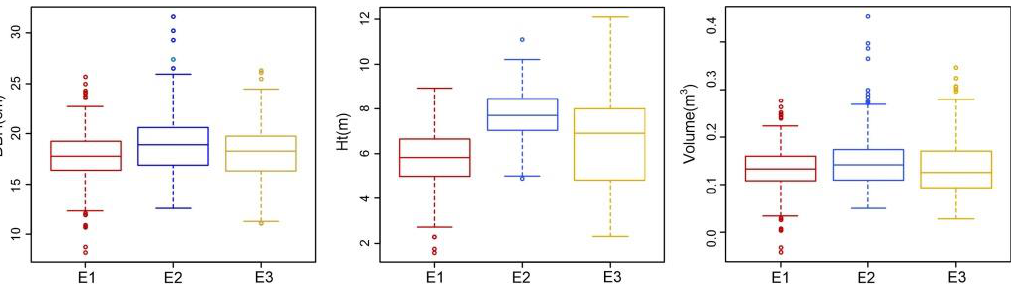
Figure 2. Box plots of DBH, Ht, and volume for clones within each site. Data points are extreme values outside the range of 1.5 times the box length. Table 3. Analysis of variance of the growth traits of the clones within each site.